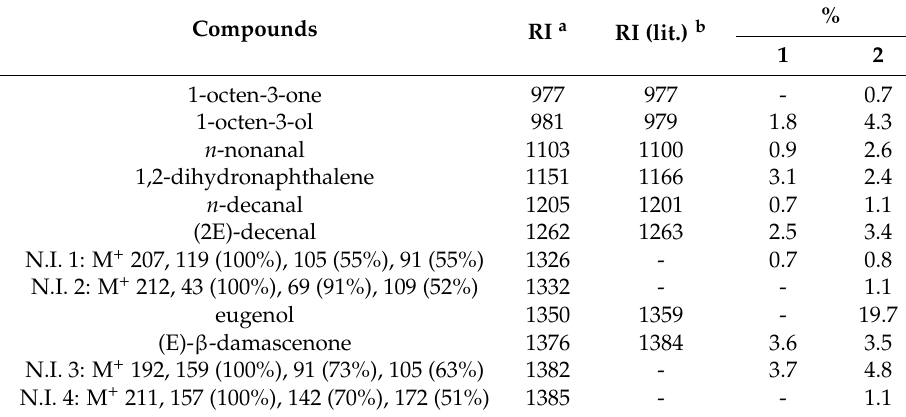
Table 1. Composition of the essential oils from the leaves of A. schaueriana collected at Estaç ã o Ecol ó